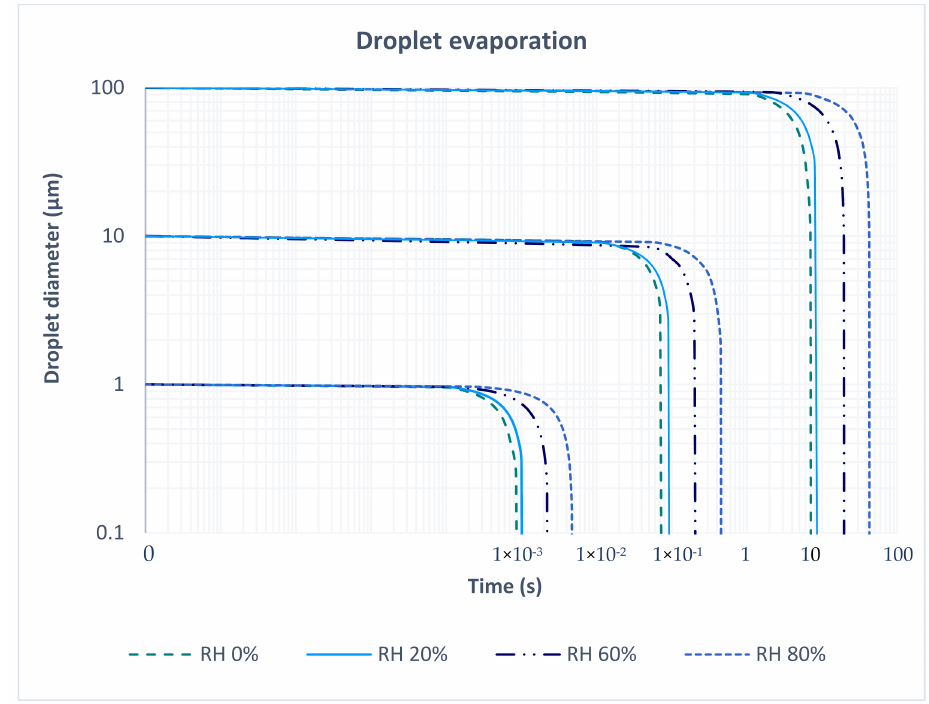
Figure 1. Evaporation of a single pure water droplet under different environment conditions, environment temperature of 293.15 K, particle temperature 310.15 K, and different droplet sizes (1 µ m, 10 µ m, and 100 µ m).